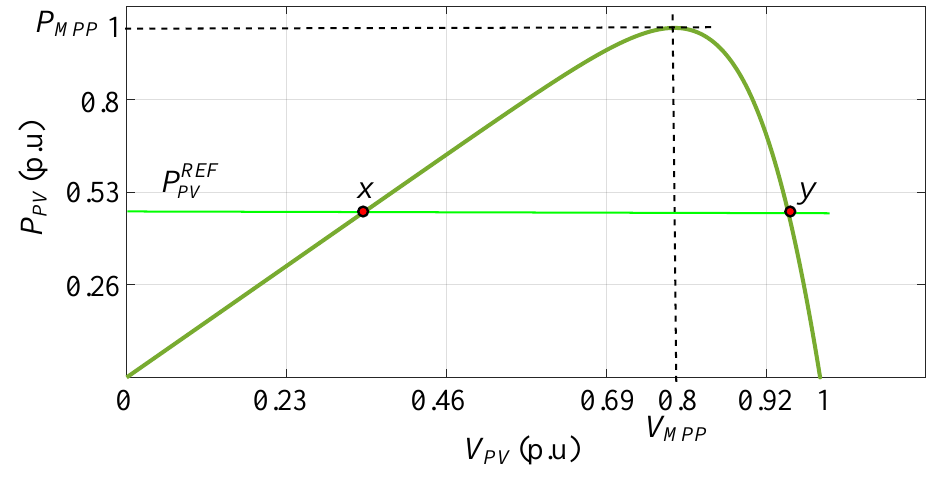
Figure 5. Traditional P - V